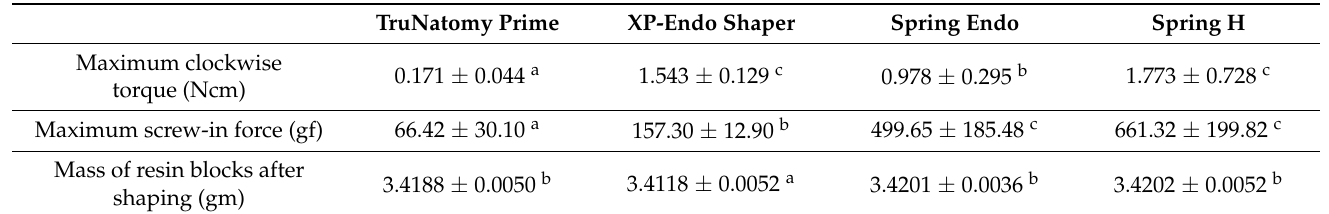
Table 4. Maximum clockwise torque and screw-in force generated during simulated canal shaping and mass of resin blocks after shaping (mean ± standard